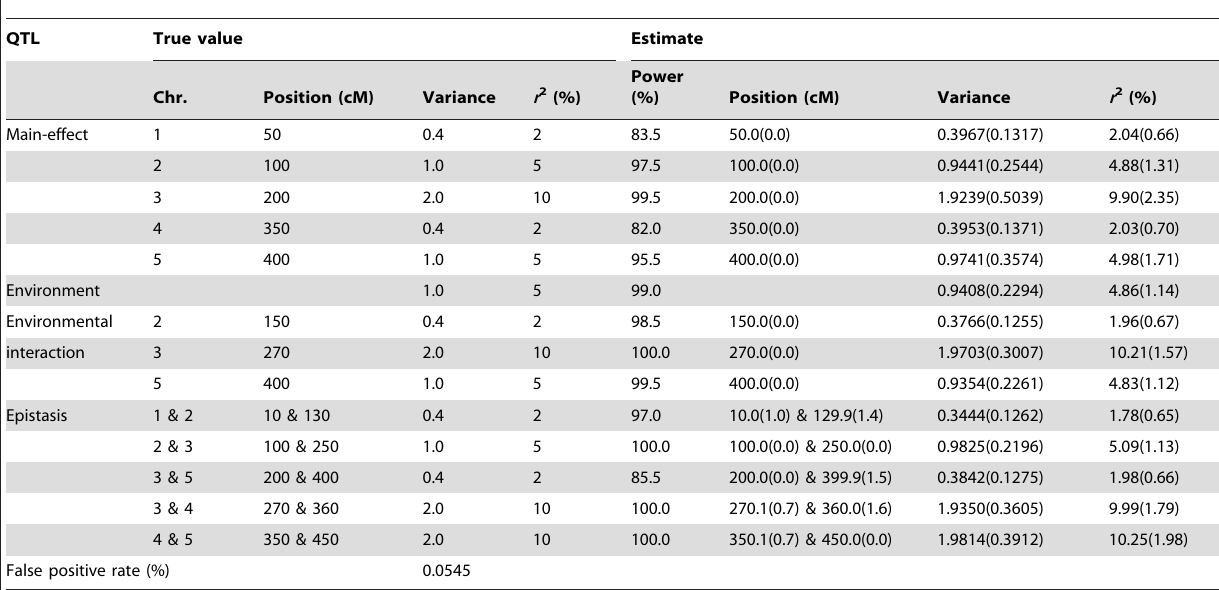
Table 5. Epistatic QTL detection in Monte Carlo simulation experiment (200